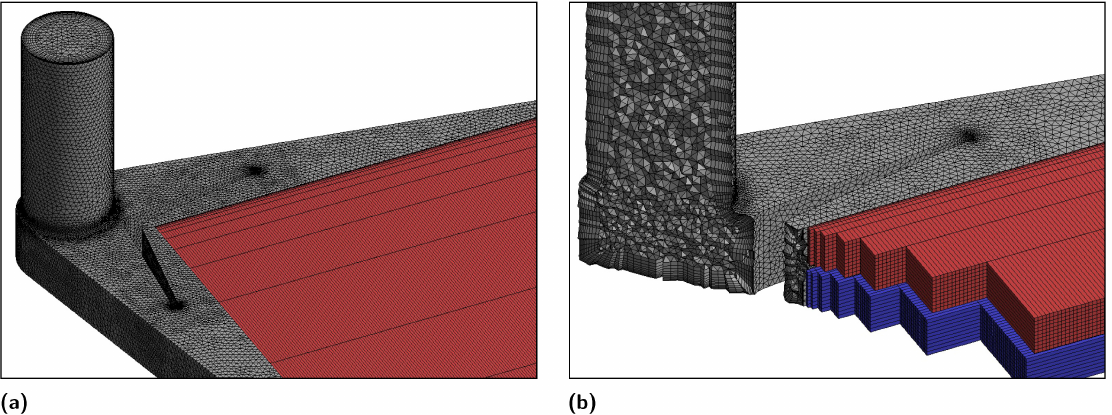
Figure 4. Mesh details showing the structure of the computational grid selected for a representative test case: ( a ) basic geometry; ( b ) angled baffle position in the inlet header.